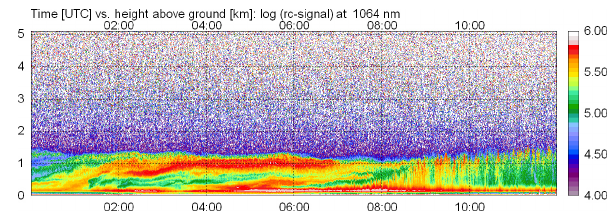
Figure 9. Time–height cross section of the range-corrected signal (in arbitrary units, logarithmic scale) of CHX-1 from 2 July 2015 (including Case A) to noon. Time is given in UTC, and the height above ground in kilometers; note that the vertical range shown here is not the full measurement range of the ceilometer.